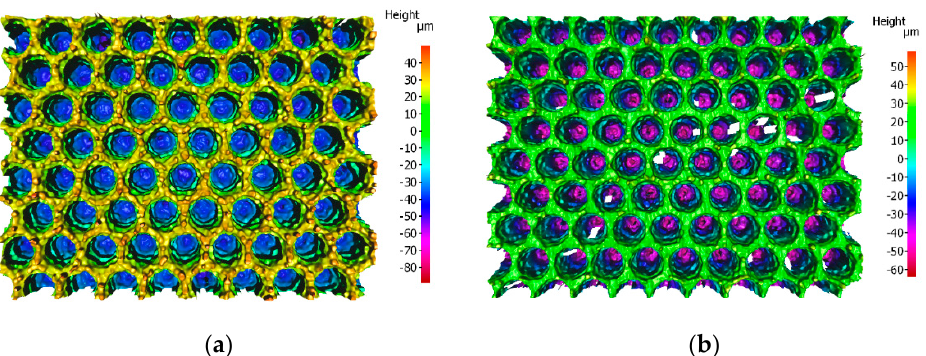
Figure 10. Comparison of the surface topographies for processing with 20 W laser ( a ) and 200 W laser ( b ).